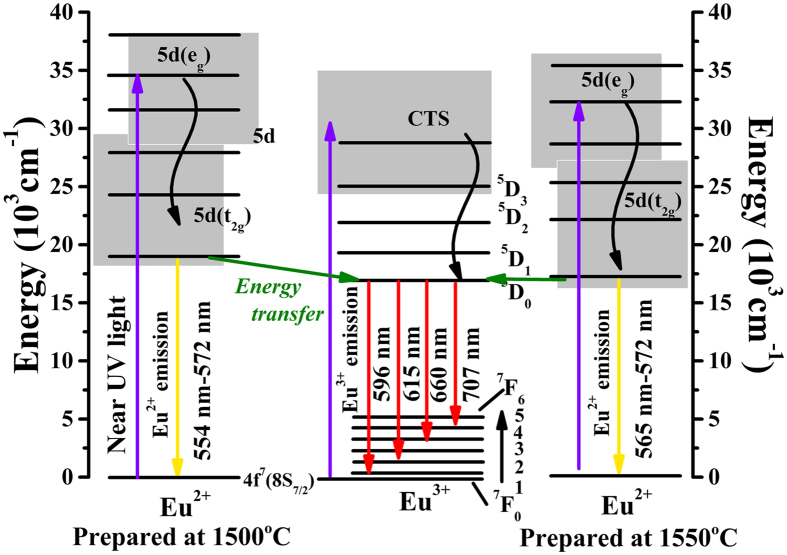
Schematic of energy transfer in LaSiO2N:0.06Eu.